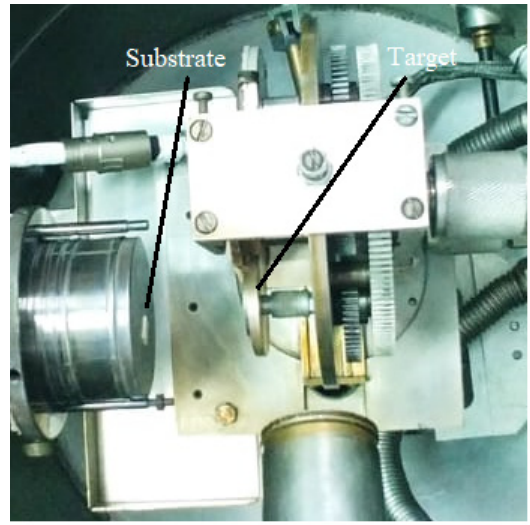
Figure 4. Photograph of the PLD setup: the heated substrate and the material target.